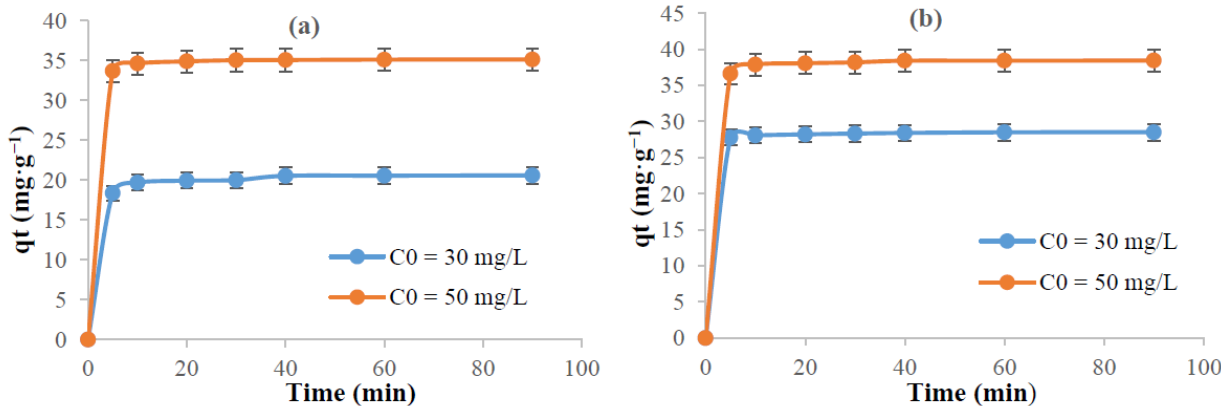
Figure 6. Effect of time on the adsorption of: ( a ) methylene blue and ( b ) crystal violet (pH = 6, T = 22 ◦ C, Volume = 10 mL, and adsorbent dosage = 0.012 g) (For each measurement, 3 replicates are done).